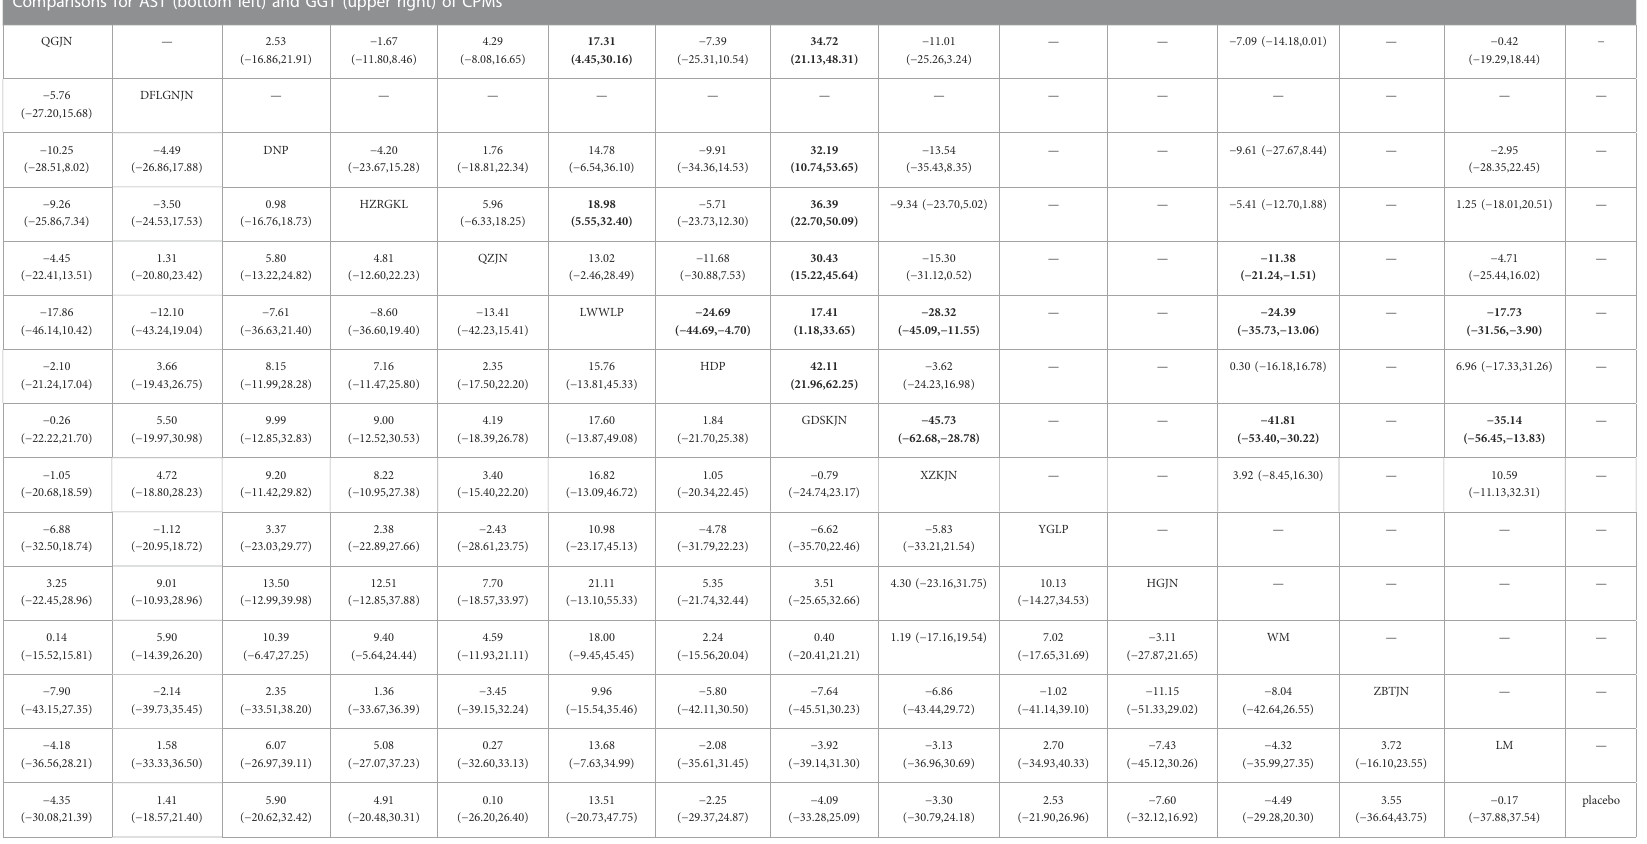
QGJN: Qianggan capsule; DFLGNJN: Dangfei Liganning capsule; DNP: Danning tablet; HZRGKL: Huazhi Rougan granule; QZJN: Qiaozhi capsule; SQZGW: Sanqi Zhigan pill. LWWLP: Liuwei Wuling tablet; HDP: Hedan tablet; GDSKJN: Gandan Shukang capsule; XZKJN: Xuezhikang capsule; YGLP: Yiganling tablet; HGJN: Hugan capsule; WM: Western medicine; ZBTJN: Zhibitai capsule; LM: lifestyle modi fi cation. Data of comparison for AST, and GGT, are MD (95%CI).The 95% con fi dence interval which does not range across 0 favors the column-de fi ning treatment and is shown in